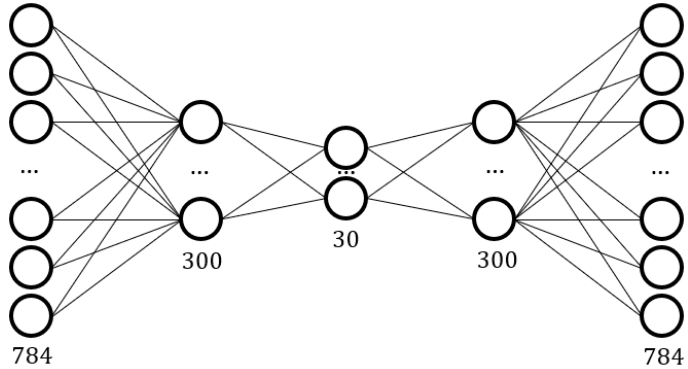
Figure 10. Network structure of the Autoencoder.